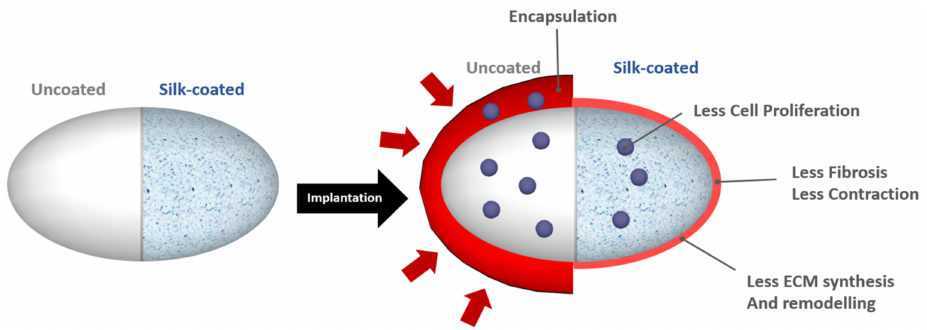
Figure 12. The schematic representation of silk coating on silicone implant and their performance on capsule contracture formation. Silk reducing the cell proliferation and ECM synthesis around the breast implants. Reproduced with permission from